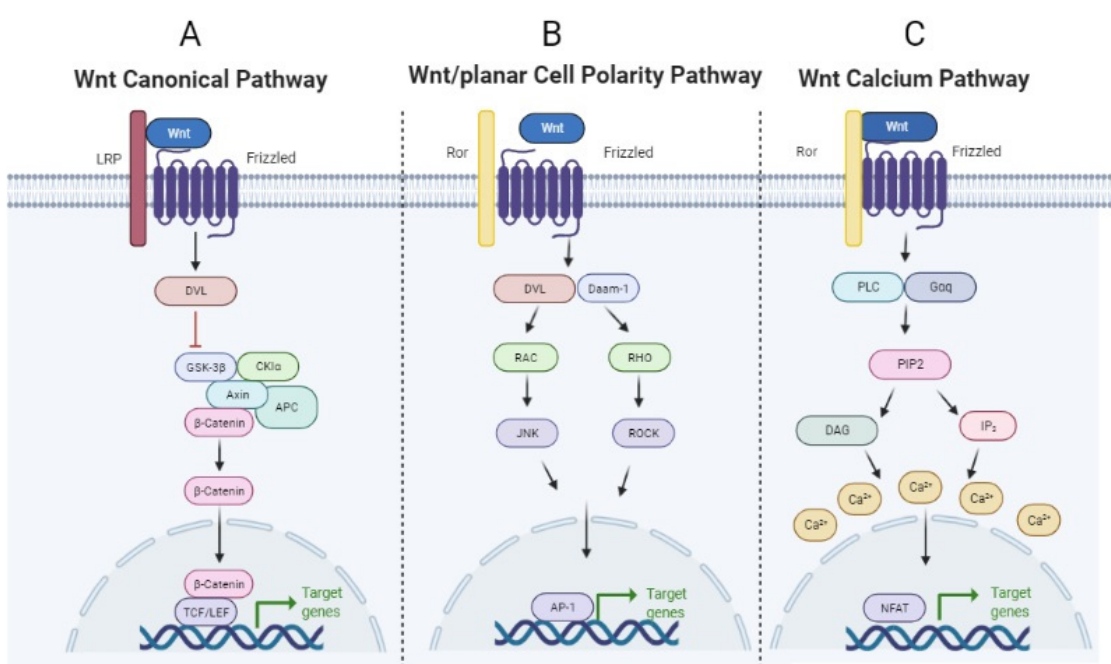
Figure 3. Scheme of the three WNT pathways. Created by Biorender.com and modified from Koni et al. [66] and Hiremath et al. [67]. et al. [66] and Hiremath et al.